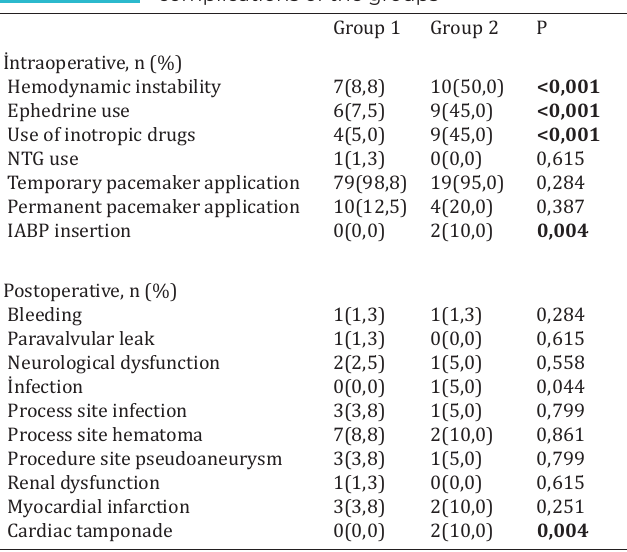
Comparison of intra and postoperative complications of the groups